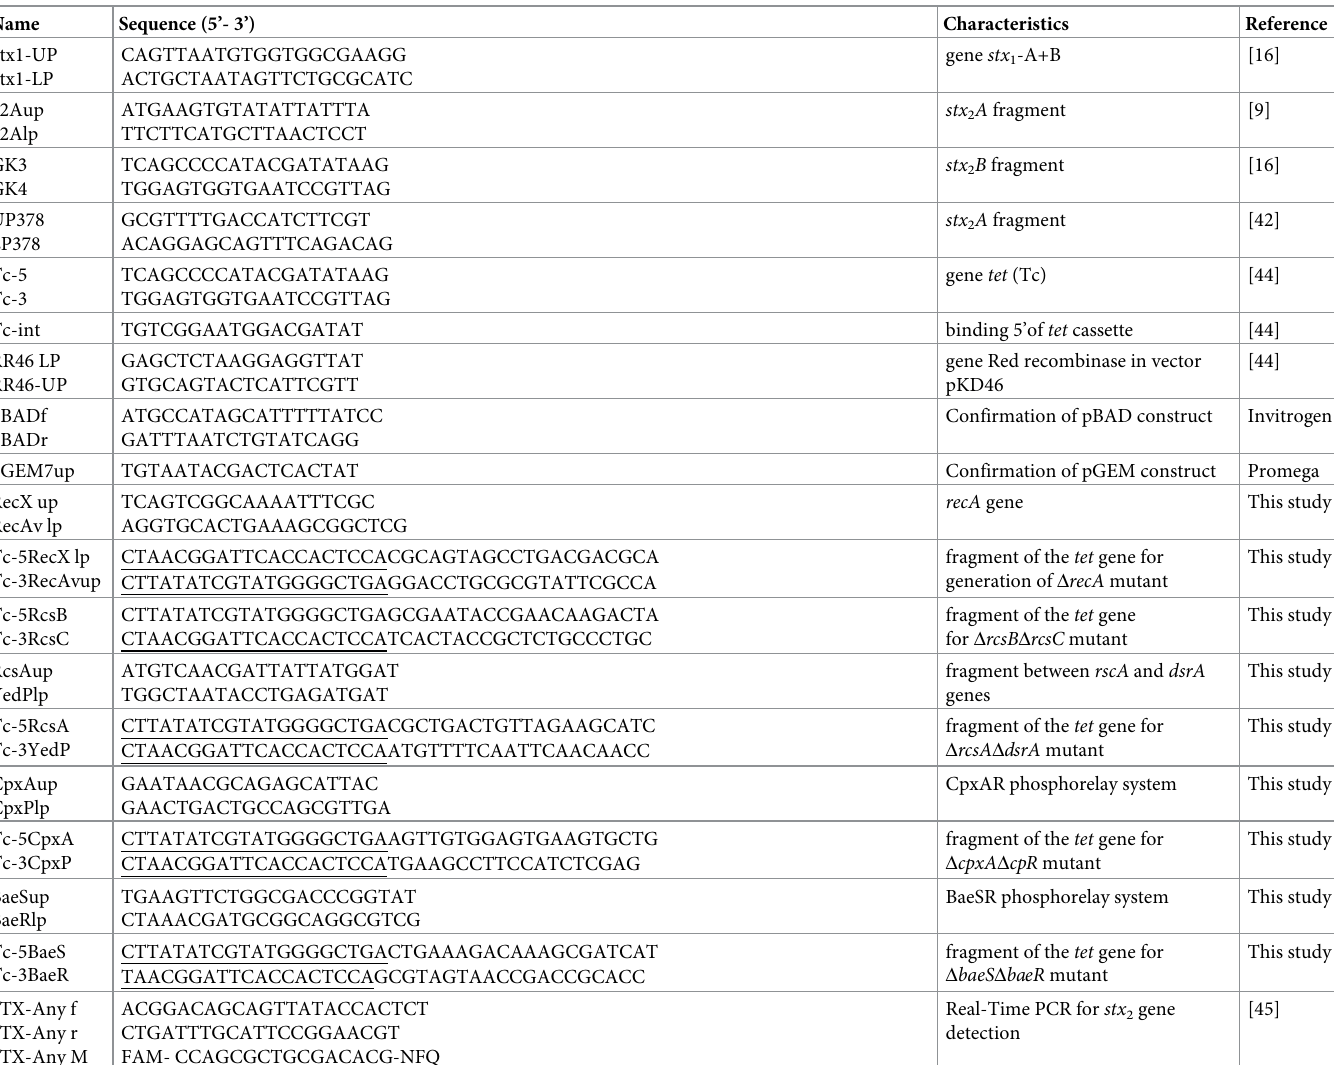
Table 2. Oligonucleotides used in this